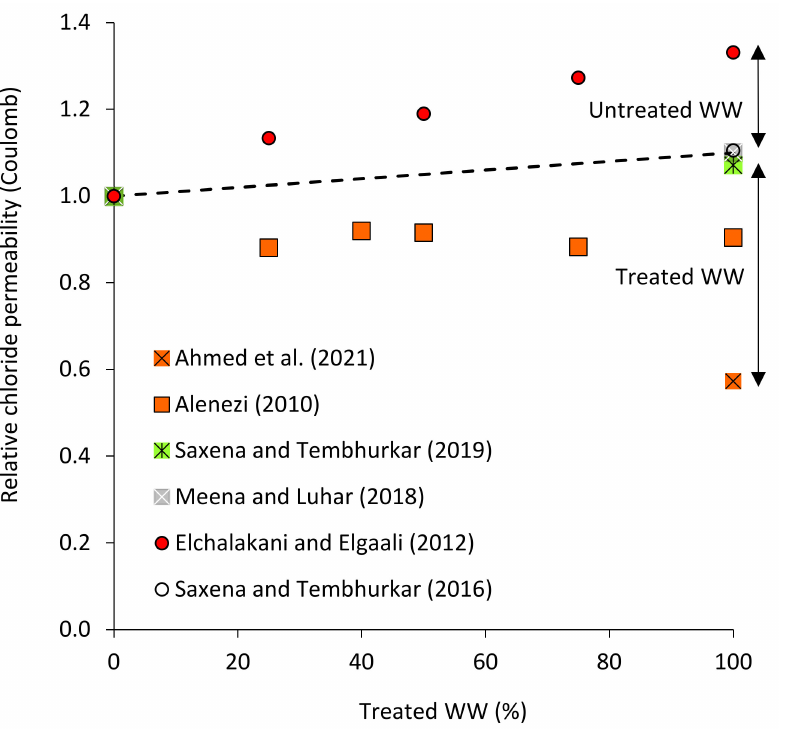
Figure 19. Relative chloride ion permeability of concrete made with treated and untraded WW.